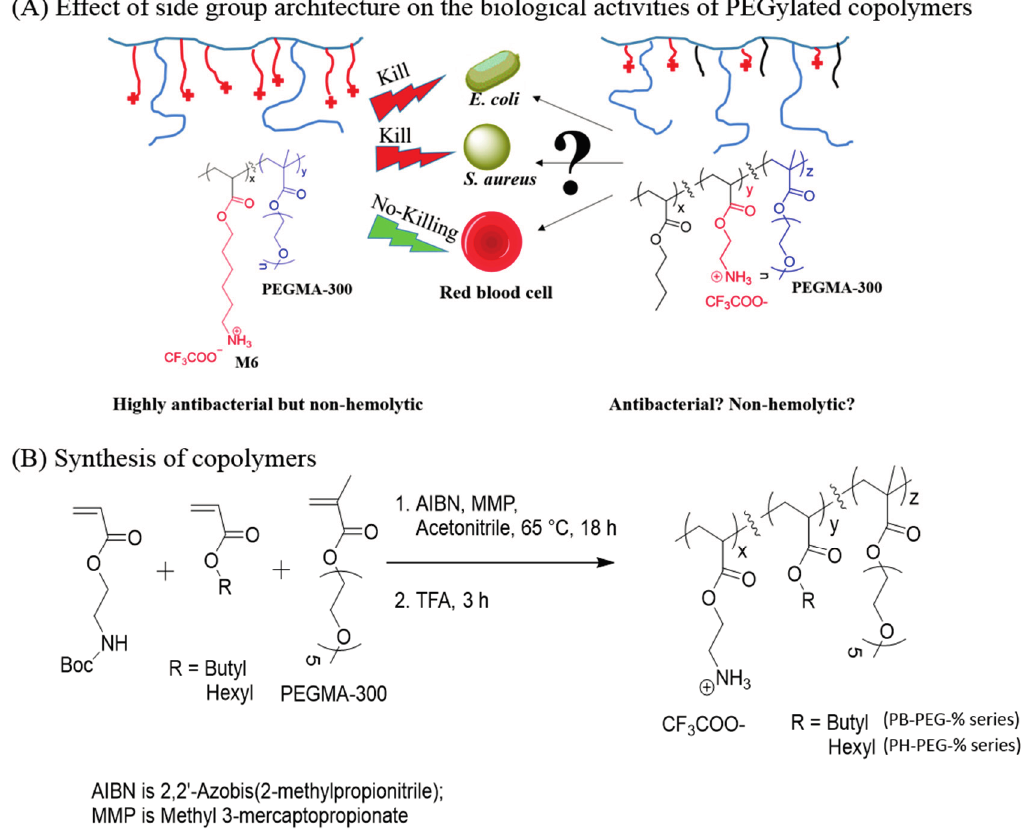
Figure 1. ( A ) Effect of relative topographical positions of cationic and lipophilic groups